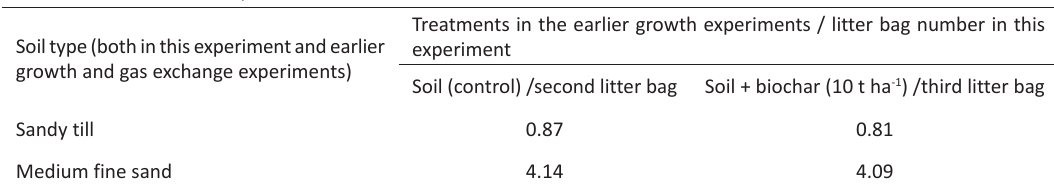
Table 2. The N content (%) of Phleum pratense leaves and shoots used in the litter bags. The biomass originated from earlier growth and gas exchange experiments conducted with the same soil and biochar types (for details see Saarnio et al. 2013, Niemi et al. 2015) Treatments in the earlier growth experiments / litter bag number in this Soil type (both in this experiment and earlier growth and gas exchange experiments)